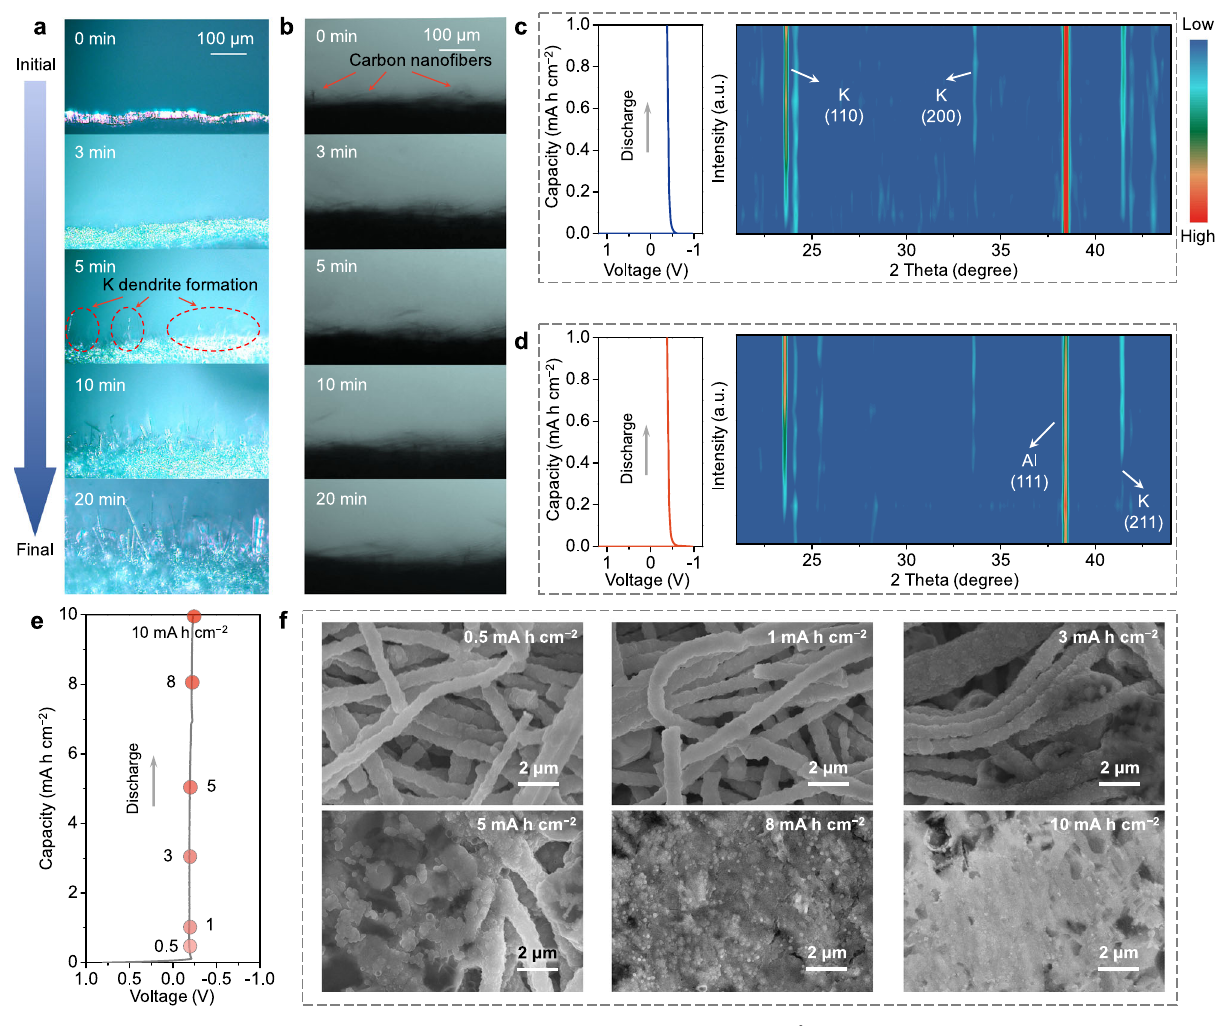
Fig. 3 | Physicochemical investigation of potassium metal deposition for var- ious potassium metal hosts. In situ optical microscopy observation of K deposi- tion on a Cufoiland b MSCNFsata current density of 6mAcm − 2 . Contour plots of operando XRD patterns for K deposition on c Al foil and d MSCNFs at a current